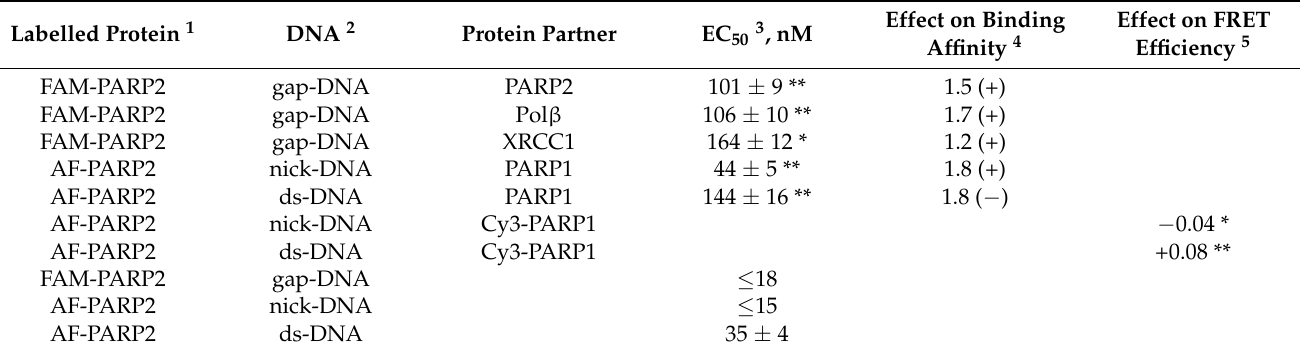
in Figure 3A. The experimentally determined volume-weighted size distribution R H value for PARP2 slightly exceeded the theoretical value for the homodimer (5.0 vs. 4.67 nm) and was significantly lower than the respective value predicted for the homotetramer (5.0 vs. 6.28 nm) (Table 3). We found that the amount of species different from the homodimer was minor: the R H values determined from three size distributions varied within the experimental error (from 4.6 ± 0.3 to 5.4 ± 0.4 nm; Table S2). Thus, we propose that the main homo-oligomeric form of PARP2 in solution exists as a dimer. Table 2. Effects of model DNAs on the PARP2 interaction with proteins.